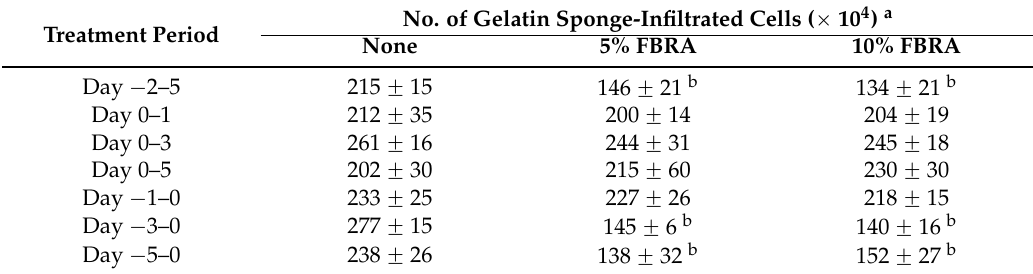
Table 4. Timing of FBRA administration for suppressing the infiltration of inflammatory cells.